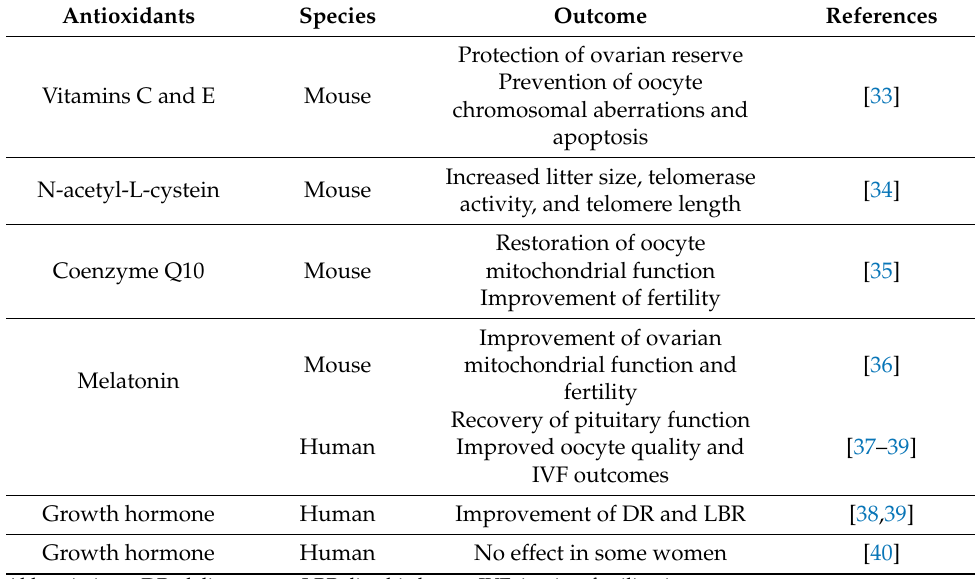
Table 2. Antioxidants in the treatment of age-related ovarian